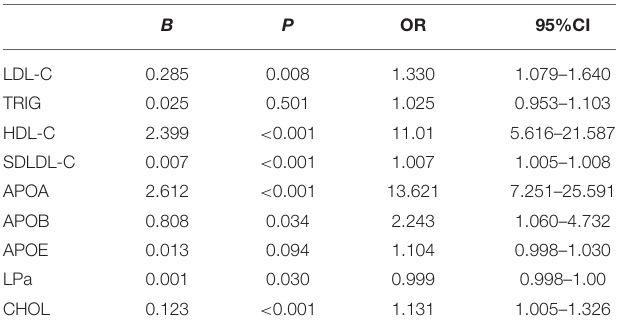
TABLE 3 | Logistic regression analysis of the association between serum lipid levels and PACG.